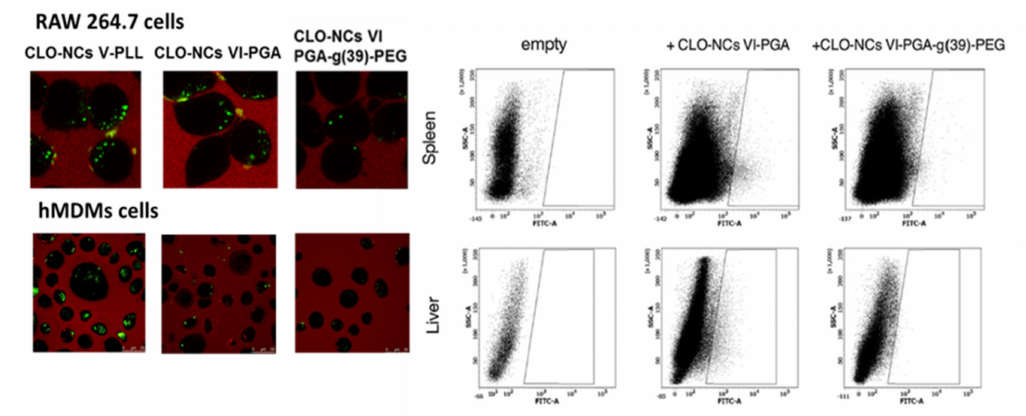
Figure 4. Left panel —In vitro CLO-NCs internalization studies performed in RAW 264.7 and hMDMs (human monocyte- derived macrophages) cells after a 2 h incubation with NCs. Right panel —In vivo-CLO-NCs biodistribution studies: the animals were injected with 150 mL suspension of CLO-NCs VI-PGA as well as CLO-NCs VI-PGA-g(39)-PEG. Flow cytometry studies were performed 4 h after injection. Detailed information